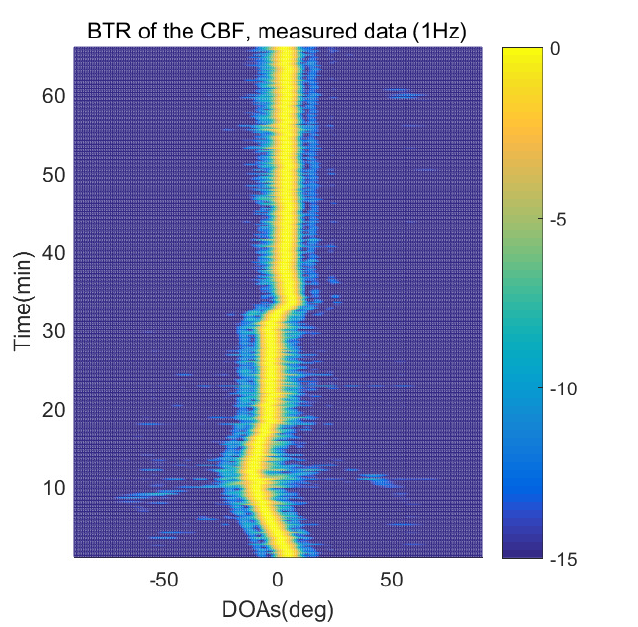
Figure 14. Bearing time records of the CBF: 66 min, pilot signal frequency = 1 Hz.